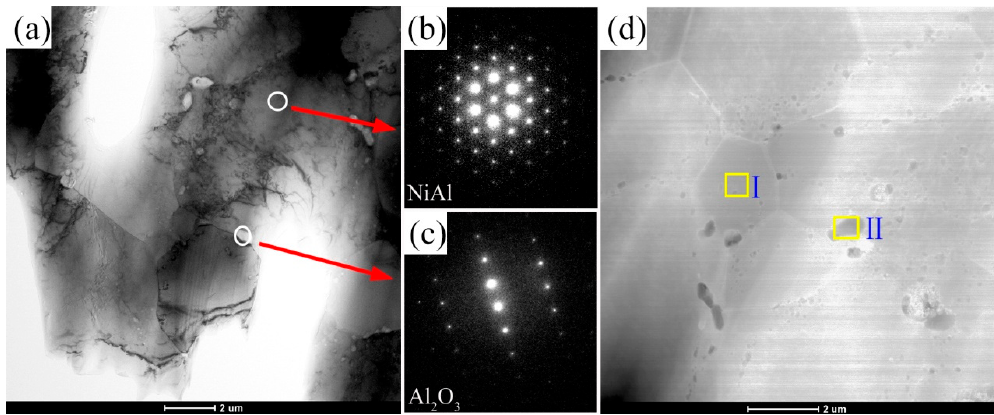
Figure 6. Transmission electron microscope (TEM) images of NiAl alloy (0 wt.%HEA): ( a ) microstructure of NiAl, ( b , c ) selected area diffraction (SAD) patterns of NiAl and Al 2 O 3 from ( a ) and STEM image ( d ).